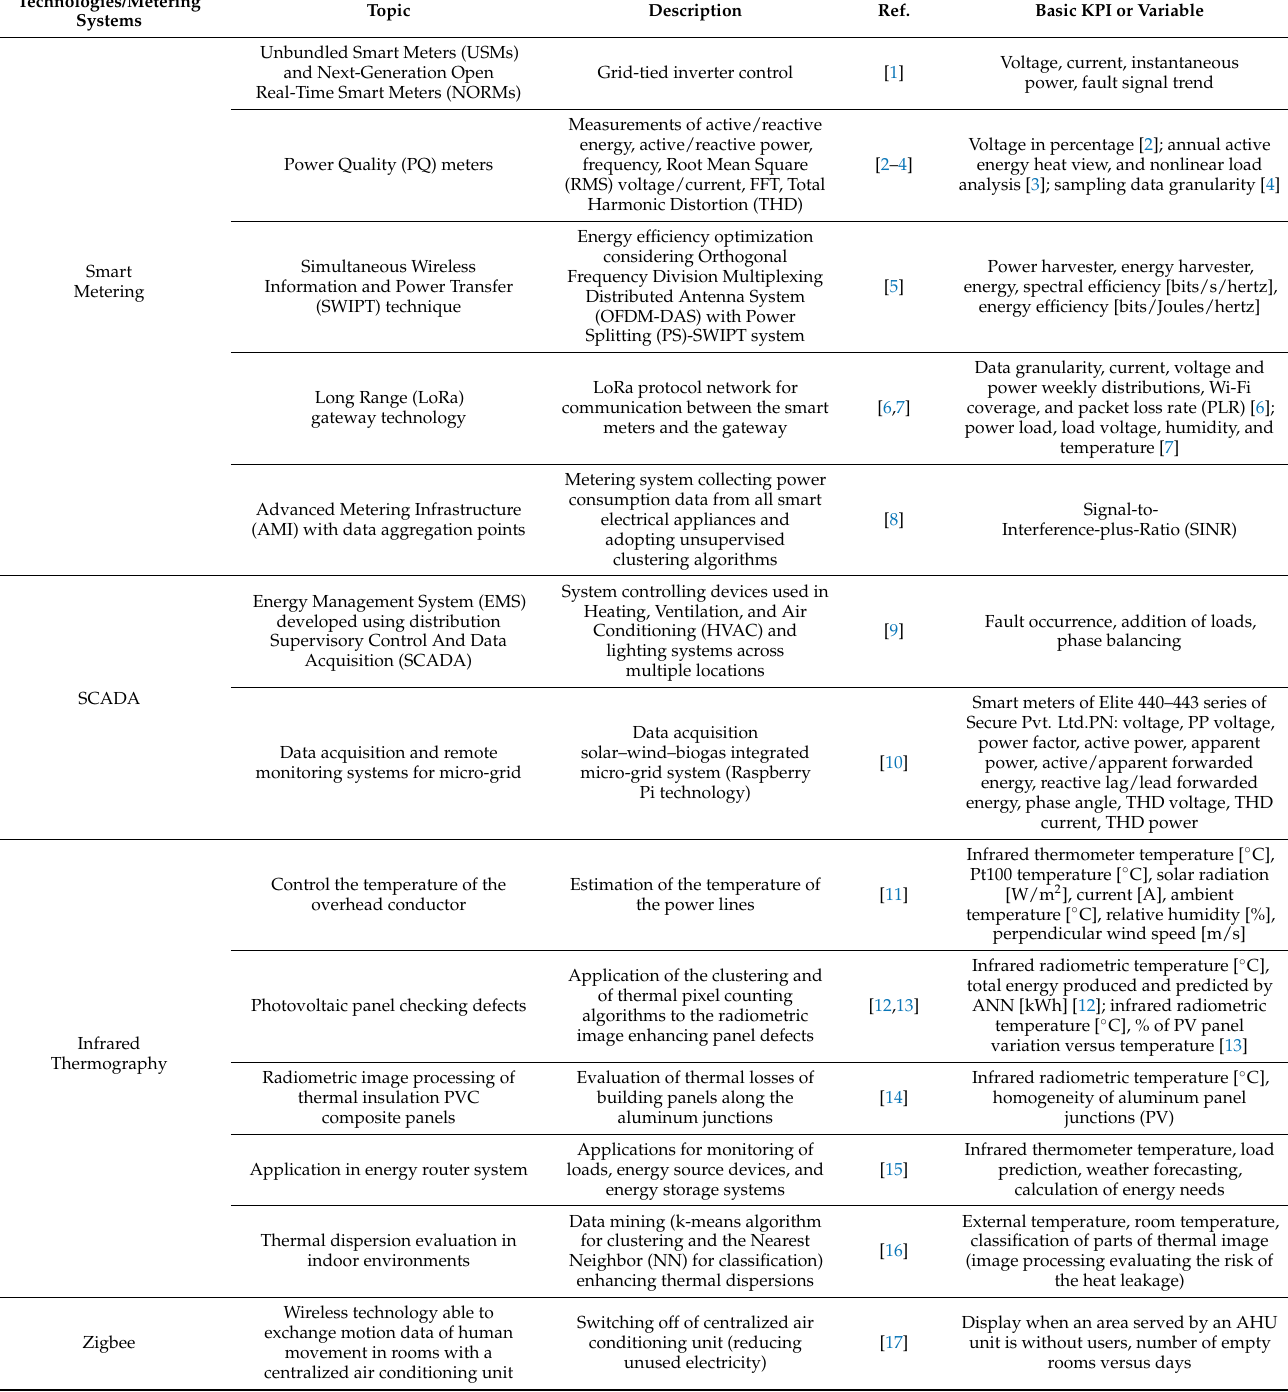
Table 1. State of the art: sensor technologies and energy metering